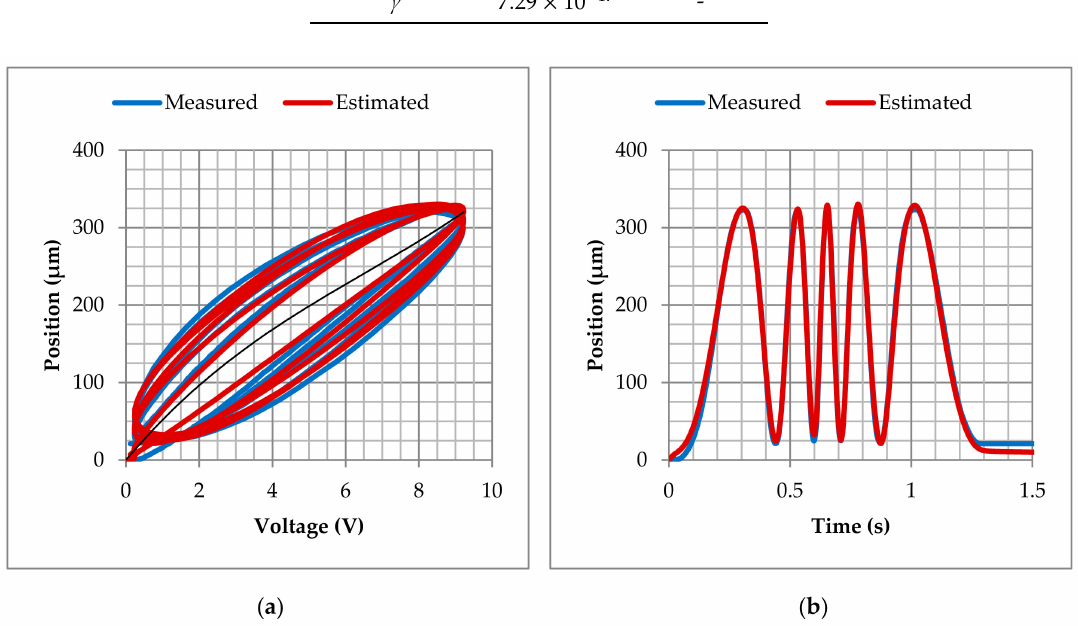
Figure 6. PEA system model in comparison with experimental data: ( a ) position versus voltage and ( b ) position versus